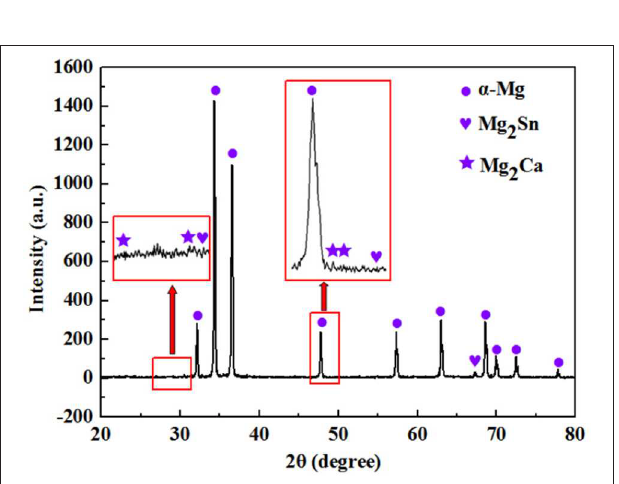
FIGURE 2 | The XRD pattern of the extruded dilute TMX-1.0